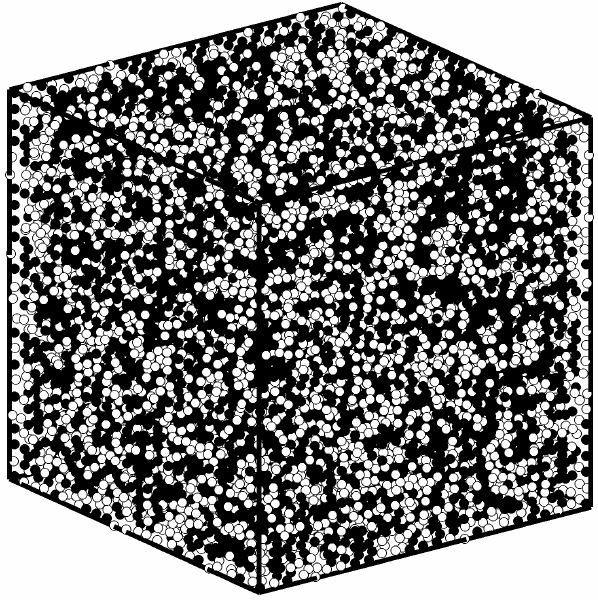
Figure 1. Initial particle arrangement for Darcy flow simulation. Black particles represent the porous medium (porosity of 0.5) and white particles represent the fluid.